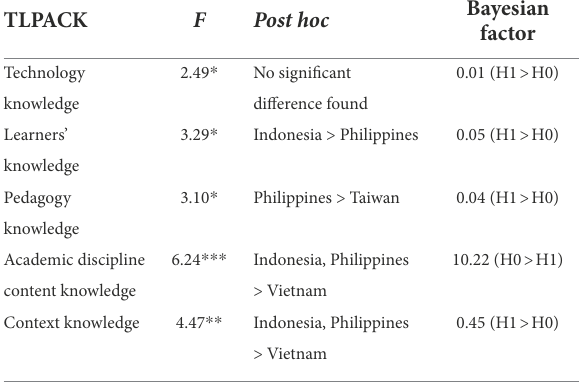
TABLE 4 Results of ANOVA and Bayesian statistics of TLPACK teachers from different countries.